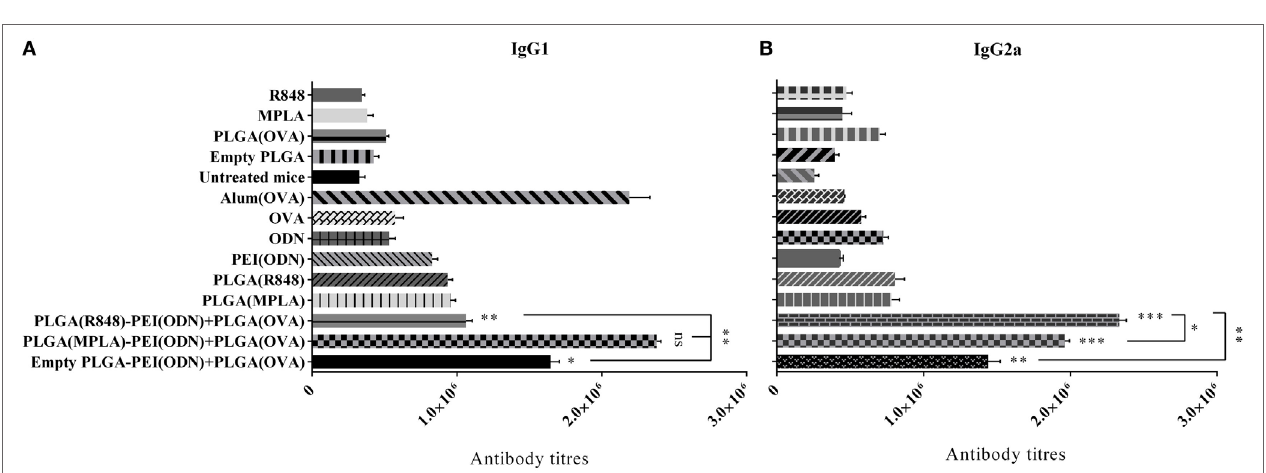
FigUre 9 | The effect of co-administration of poly(lactic-co-glycolic) acid (PLG)A [ovalbumin (OVA)] nanoparticles along with PLGA [monophosphoryl lipid A (MPLA) or resiquimod (R848)]/polyethylenimine core–shell complexed with cytosine–phosphorothioate–guanine oligodeoxynucleotide (CpG ODN) on IgG1 and IgG2a isotype responses in immunized BALB/c mice. The IgG1 and IgG2a antibody titers in the serum samples were measured by enzyme-linked immunosorbent assay. IgG1 (a) and IgG2a (B) isotype antibody titers 4 weeks after primary immunization (mean ± SD with three mice per treatment group). *** P < 0.001, ** P < 0.01, and * P < 0.05 (one-way analysis of variance). The asterisks located on top of error bars showed comparison of significance between the main [dual toll-like receptor (TLR) agonist] and control (OVA + aluminum hydroxide) group and the asterisks located on top of the lines showed comparison between the main (dual TLR agonist) groups.